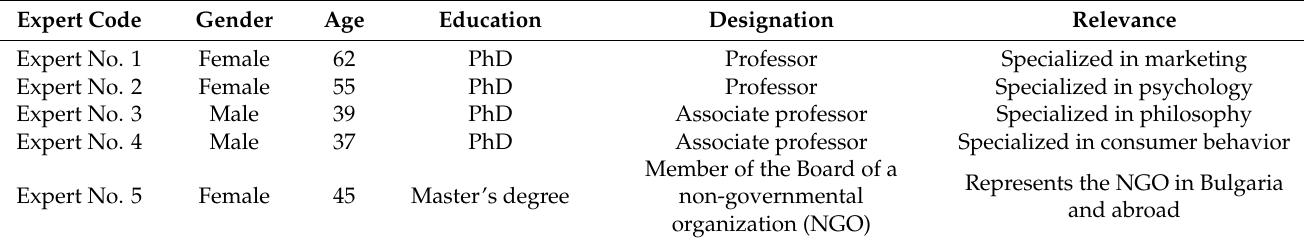
Table 3. Demographic profile of the content validity